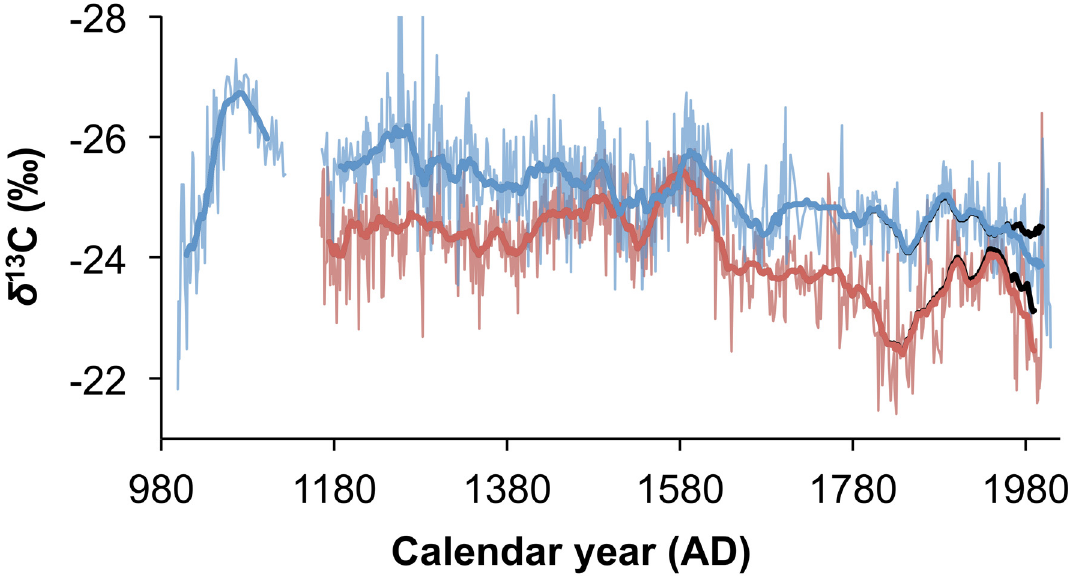
Fig 5. Comparing the Mapungubwe and Pafuri δ 13 C records. The average Mapungubwe δ 13 C record (red) and biwieght mean (bold red) has similarities and differences when compared with the Pafuri δ 13 C record (blue) and biwieght mean (bold blue). The black lines represent the biweight mean δ 13 C records from Mapungubwe and Pafuri without correcting for the intrinsic water use efficiency effect caused by elevated atmospheric CO 2 concentrations since AD